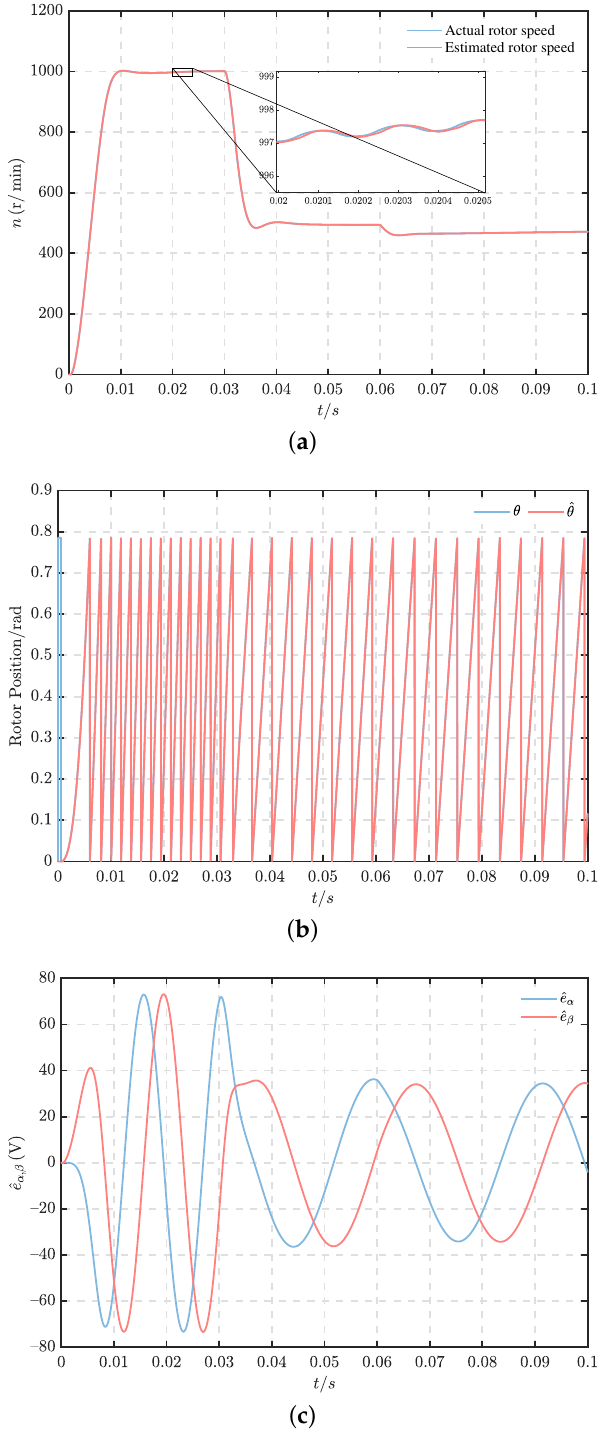
Figure 14. Responses of simulation with improved SMO combined with feedforward PLL